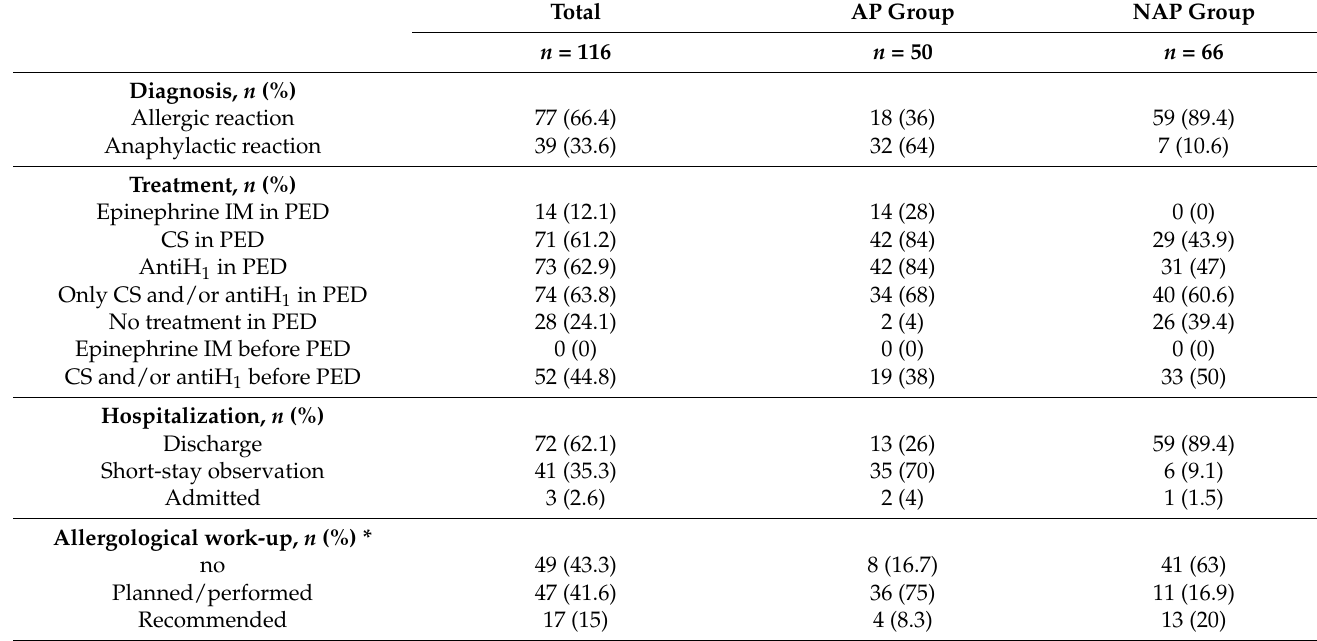
Table 4. PED management of 116 pediatric patients referred for suspected anaphylaxis. AP =